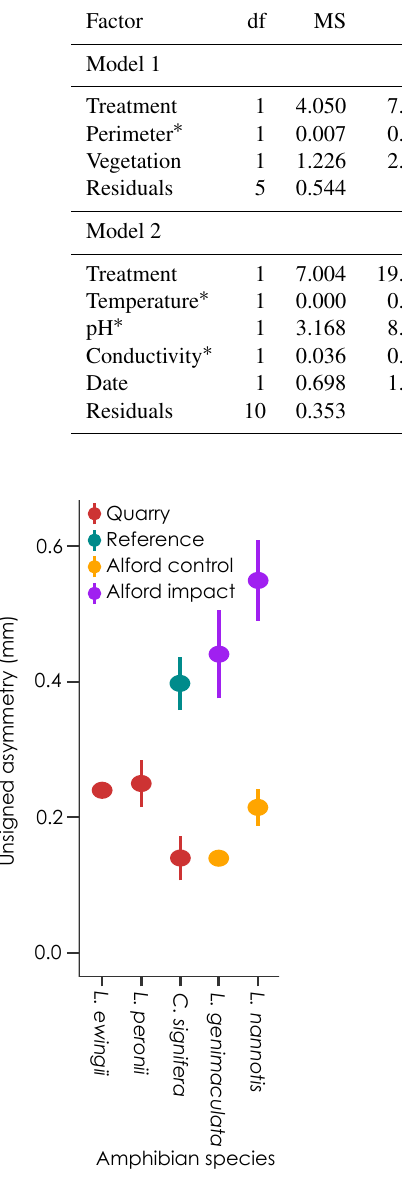
Figure 3. Levels of developmental instability (DI; quantified as un- signed asymmetry) for the three frog species occurring at quarry and reference wetlands. Mean DI values are also shown from Al- ford et al. (2007) for informal comparison. Frog populations from Alford control sites remained stable, whilst those from impact sites exhibited substantial decline following a period of increasing